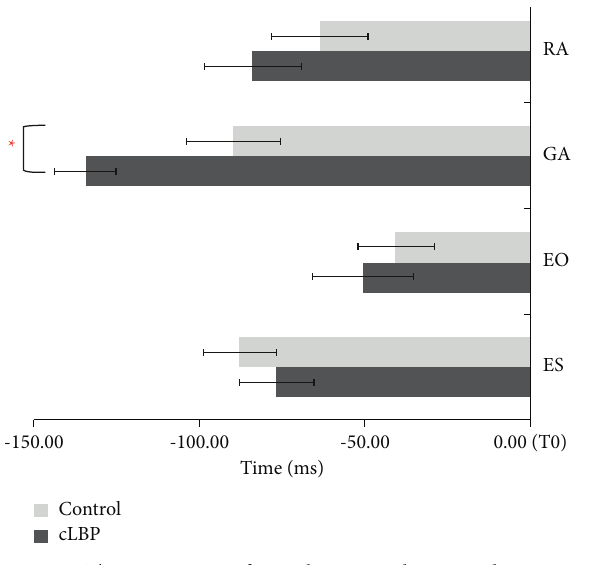
Figure 4: The onset time of muscle activity between the partici- pants in the cNLBP and control groups in the internal perturbation task.